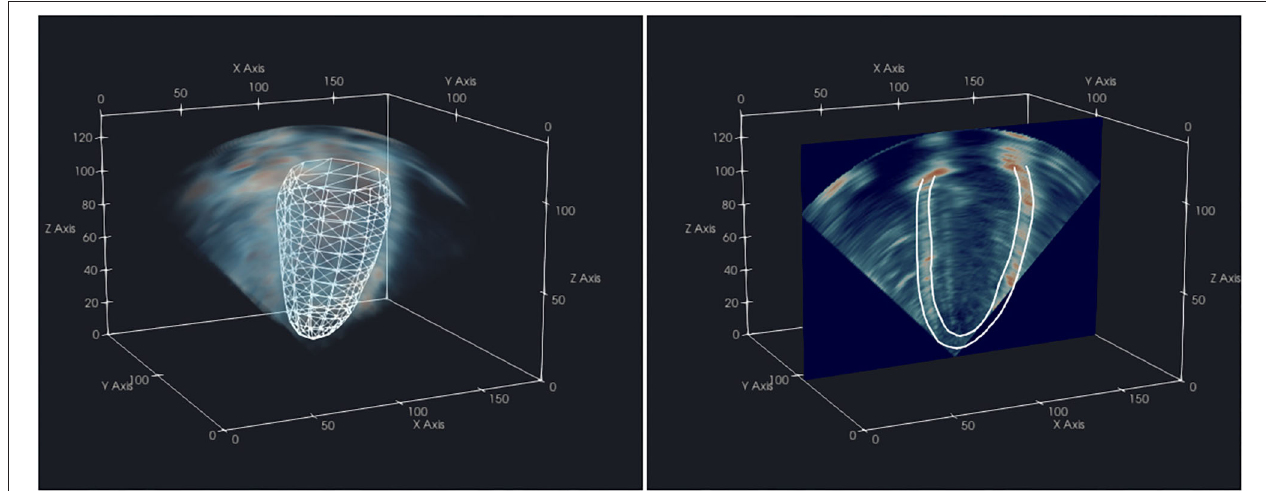
FIGURE 2 | Visualization of a CMR-derived LV endocardial surface mesh aligned with the corresponding 3D-echo volume (left) from the same subject, and 2D slice with resultant endocardium and epicardium contours (right) in ParaView 5.8.0.